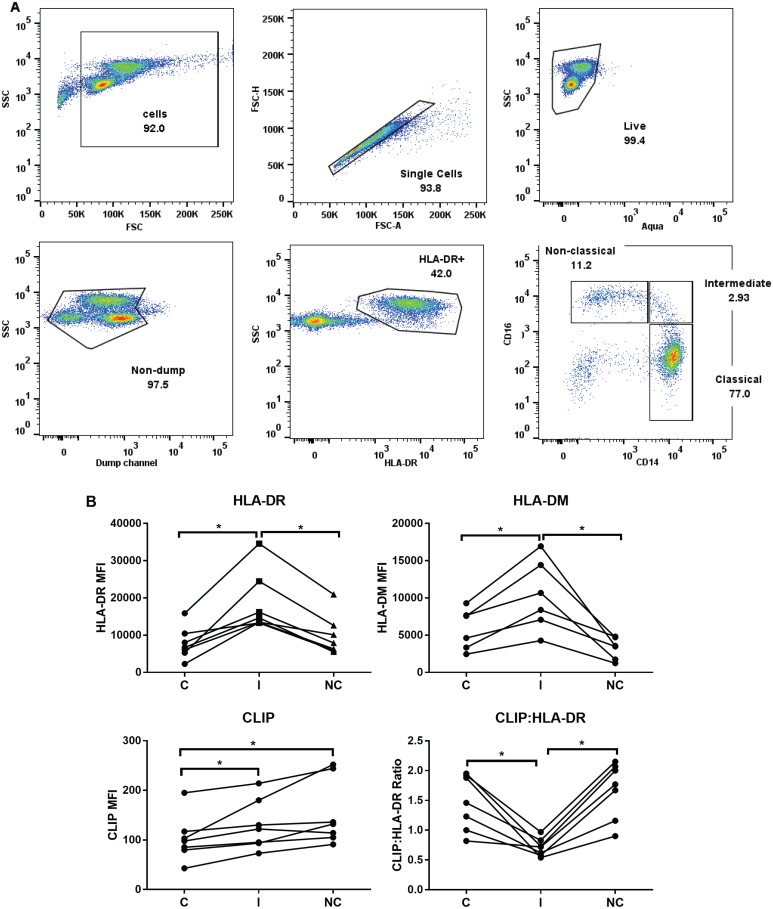
Profile of sorted, unstimulated monocytes in culture for 20–24 h is similar to monocytes within PBMC.(A) Flow cytometry gating scheme depicting the gating strategy used to identify the three monocyte subsets for sorting. Isolated PBMCs, enriched for monocytes (see Methods) were gated on a FSC x SSC plot; single, live cells were selected. Cells negative for neutrophils, and T, B, NK and Dendritic cells were further selected (‘non-dump’), and HLA-DRxSSC was used to identify monocytes (HLA-DR+). Gates for monocyte subsets based on CD14 and CD16 expression were determined using respective FMO controls. (B) Median fluorescence intensity (MFI) of surface HLA-DR, HLA-DM, surface CLIP and CLIP:HLA-DR ratios from 7 individual sorted samples (except HLA-DM, n = 6). Wilcoxon matched-pairs signed rank test was used for group to group comparison. Statistical significance represented by asterisk: *, p < 0.05. C: Classical; I: Intermediate; NC: Non-classical.